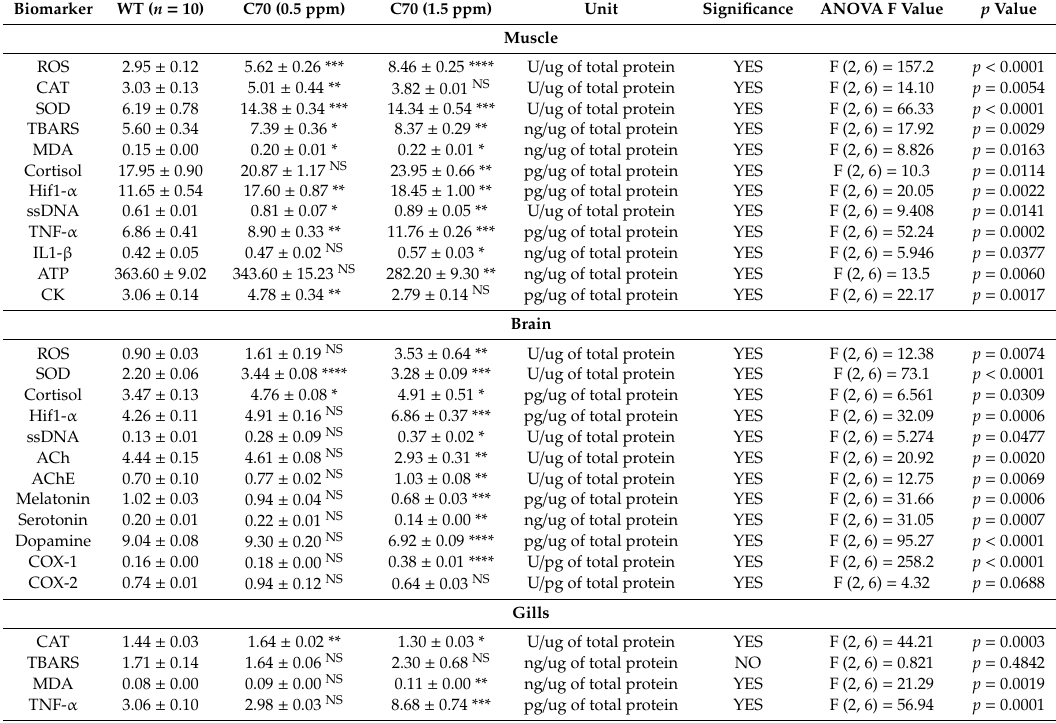
Table 1. Comparison of biomarker expression in the muscle, brain, and gill tissues in C 70 NP-exposed zebrafish. Data are expressed as the mean ±